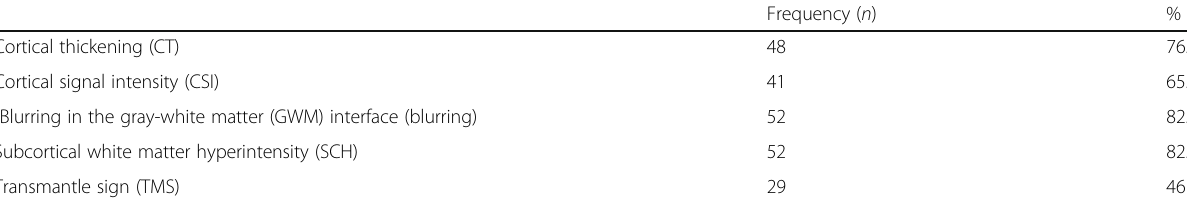
Table 5 Distribution of FCD cranial MRI findings